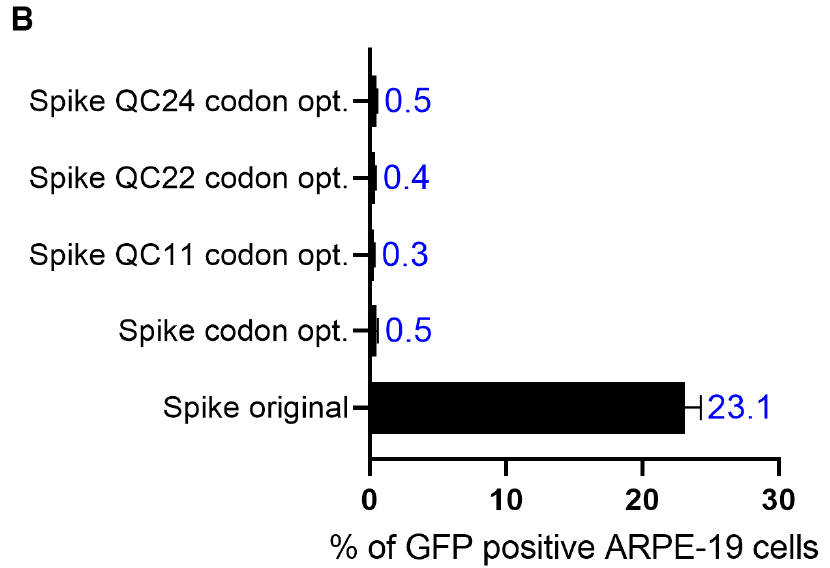
Figure 7. Infection of ARPE-19 cells with Expi293 produced pseudovirions: ( A ) GFP fluorescence analysis. Experiments were conducted in duplicate and repeated several times; scale bar = 180 µ m; ( B ) %GFP-positive cells measured by Cytation7. Error bars indicate the standard deviation.